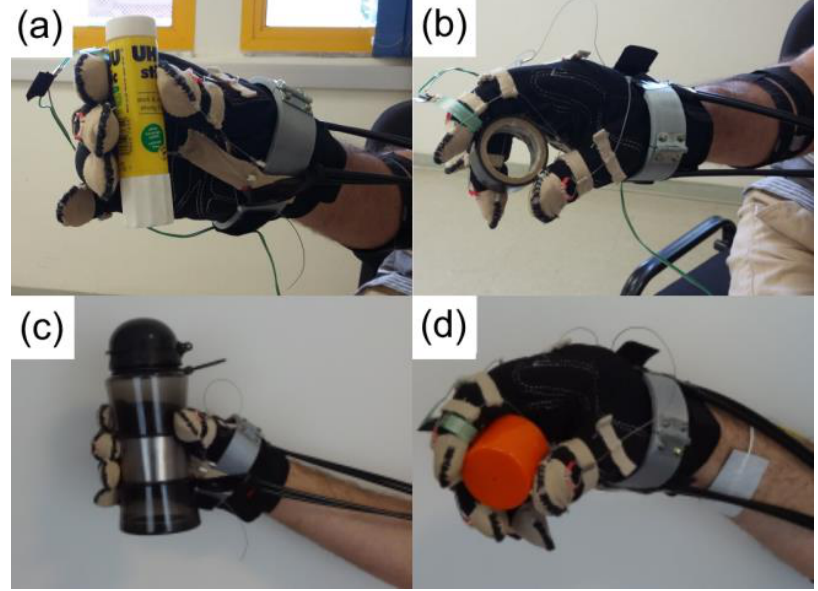
Figure 6. Objects used in the experiments: ( a ) glue stick, ( b ) adhesive tape roll, ( c ) bottle, and ( d ) toy.